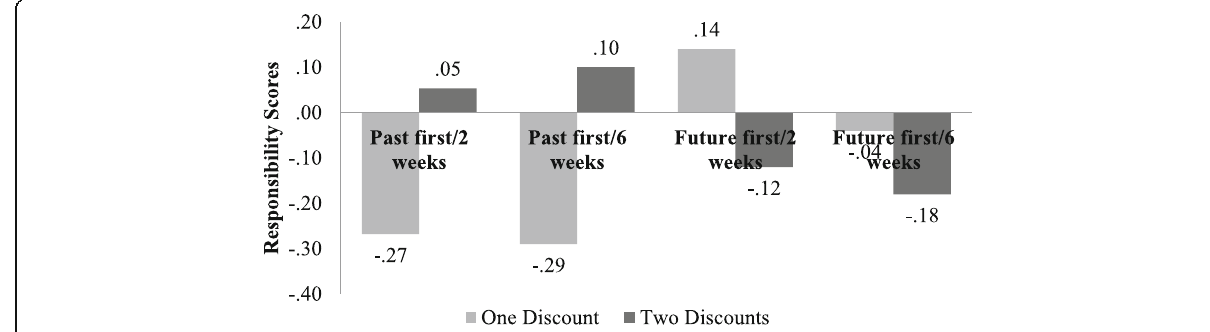
Fig. 2 Mean responsibility scores for the scenarios with one discount and two discounts in all four